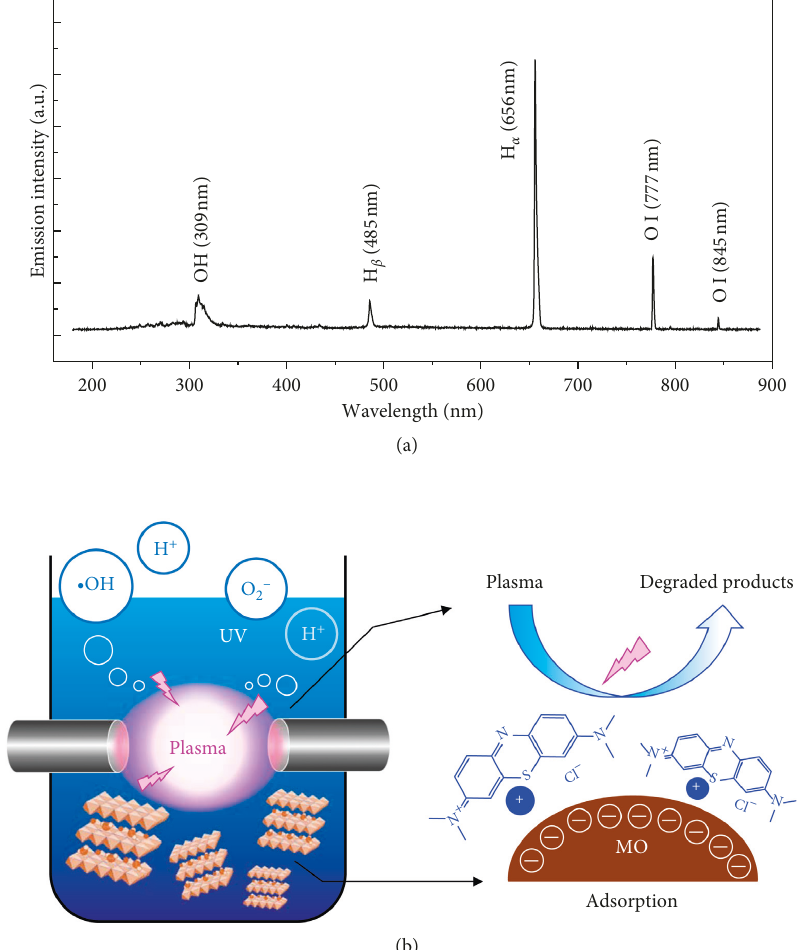
Figure 5: (a) OES spectrum collected during plasma discharging in aqueous solution, and (b) schematic presentation of the adsorbent/ plasma system for pollutant removal in aqueous